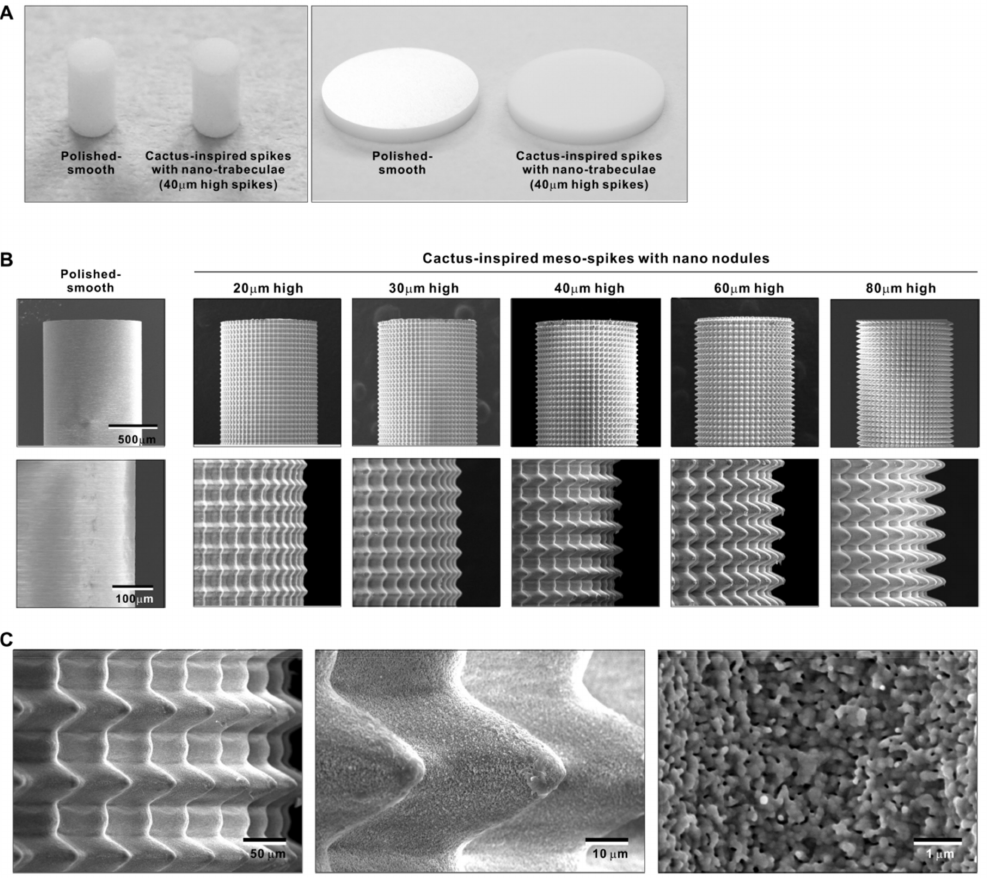
Figure 2. Creation of bio-inspired meso- and nano-scale hybrid textured zirconia. ( A ) Photographs of experimental zirconia samples made in cylinder and disk forms. Shown are a polished-smooth surface and a 40 µ m-high spiked surface as a representative laser-etched zirconia sample. ( B ) Low-magnification SEM images of the polished cylinder zirconia and the meso- and nano-scale textured cylindrical zirconia with various heights of meso-spikes. The meso-scale spikes resembled cactus prickles. ( C ) High-magnification SEM images of the meso- and nano-scale textured zirconia with 40 µ m-high spikes, vividly capturing the co-existence of cactus-inspired meso-spikes and nano-scale interwoven architecture resembling trabecular